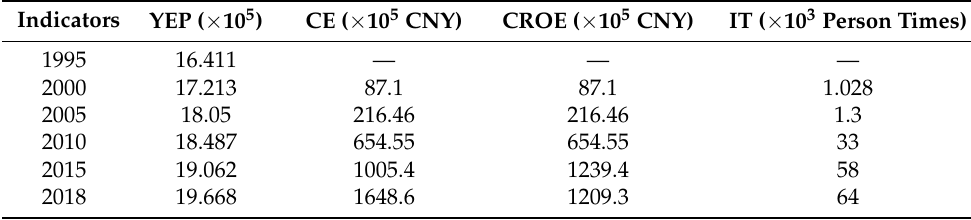
Table 7. Dongying cultural indicators from 1995 to